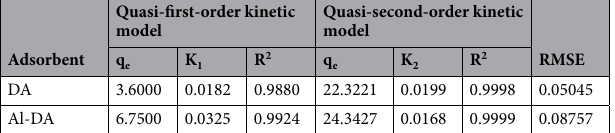
Table 2. Quasi-first-order and quasi-second-order kinetic fitting